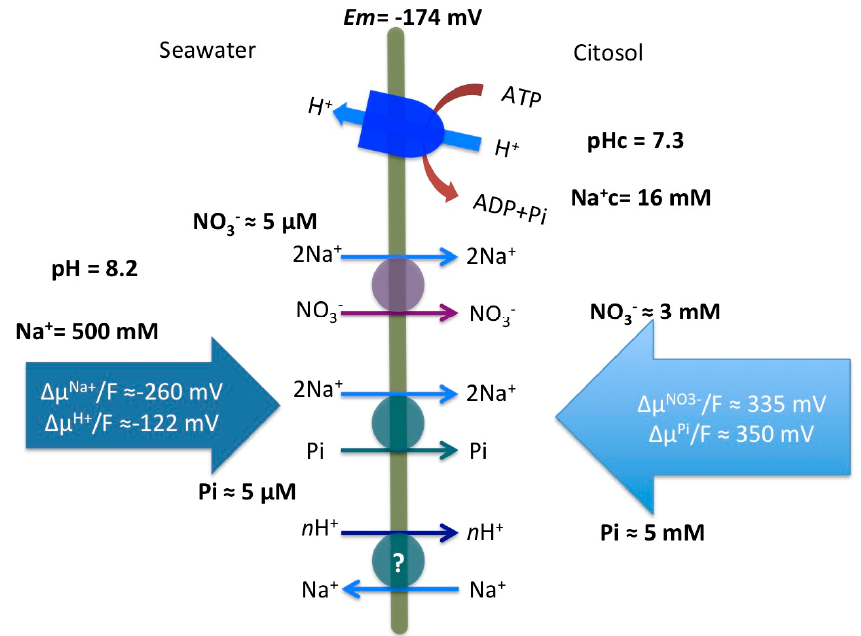
Figure 5. Energization model and stoichiometry for plasma membrane high-affinity NO 3 − and Pi transporters in mesophyll leaf cells of P. oceanica. A Na + /H + antiporter is also indicated as a putative mechanism to maintain the sodium gradient. Cytosolic and seawater ion concentrations and the calculations of the electrochemical potential gradients, included on the big arrows ( ∆μ /F; mV), are discussed in the text.